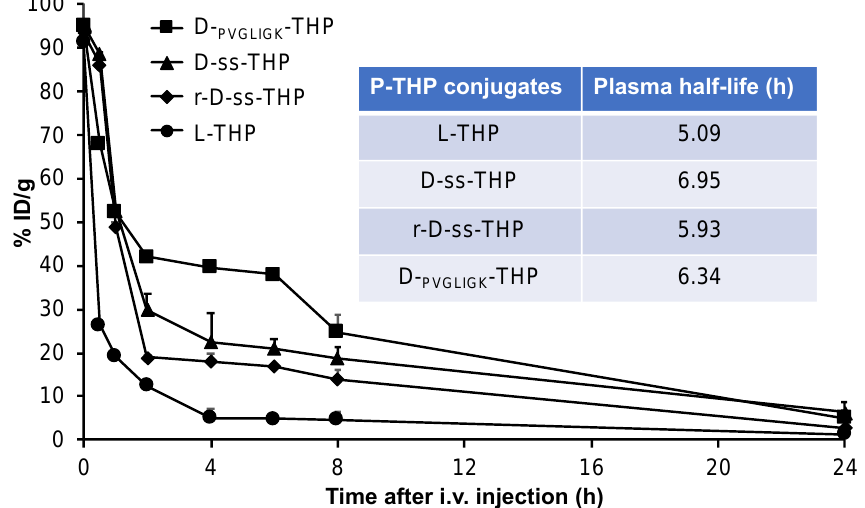
Figure 8. Pharmacokinetic properties of P-THP conjugates in the blood of ddY mice. Different P-THPs were injected i.v. into ddY mice via the tail vein. After scheduled time, blood was collected from the tail vein, and the blood concentrations of P-THPs were measured and quantified by HPLC. Data are mean ± SE. See text for details.